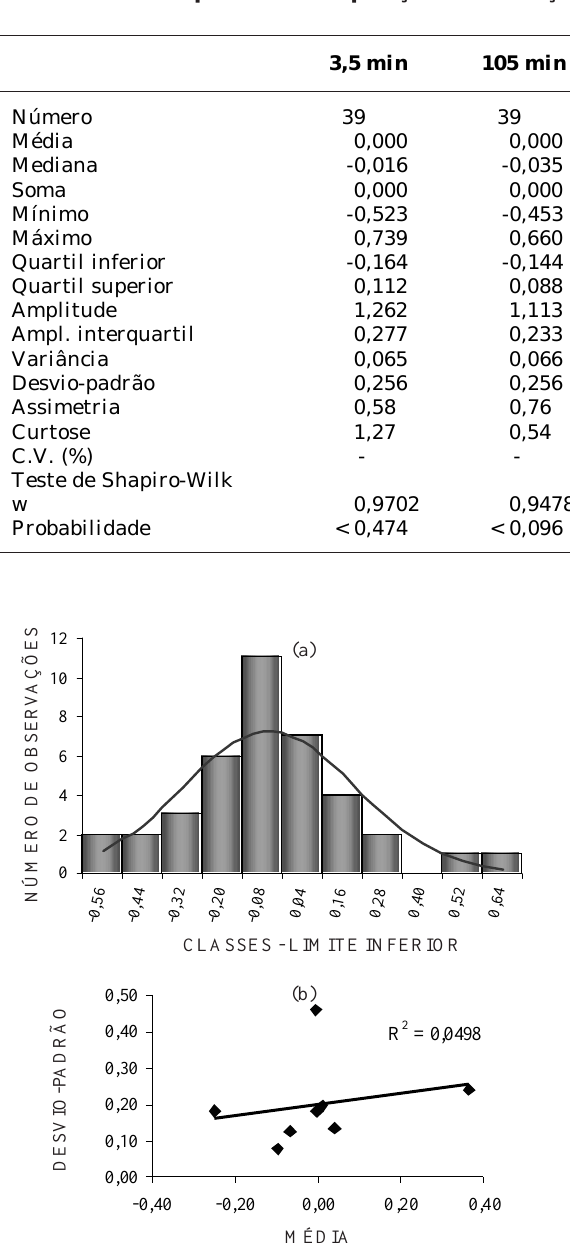
Figura 4. Distribuição de freqüências (a) e desvio- padrão de acordo com a média (b) para subamostras de 5 observações para os resíduos da regressão do logaritmo da taxa de infiltração após 3,5 min.